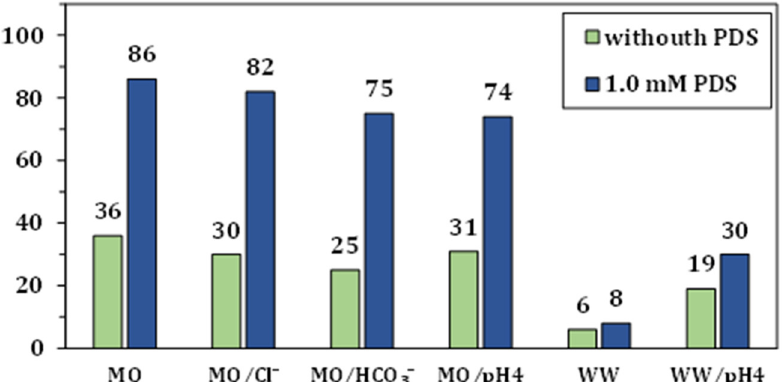
Figure 10. The effect of biologically treated domestic wastewater (ww), pH, Cl − (3.4 × 10 − 3 M), and HCO 3 − (8.6 × 10 − 3 M) on the transformation of SMP (c 0 (SMP) = 1.0 × 10 − 4 M; c 0 (PDS) = 1.0 × 10 − 3 M) in BiOI suspension irradiated with Vis LED.